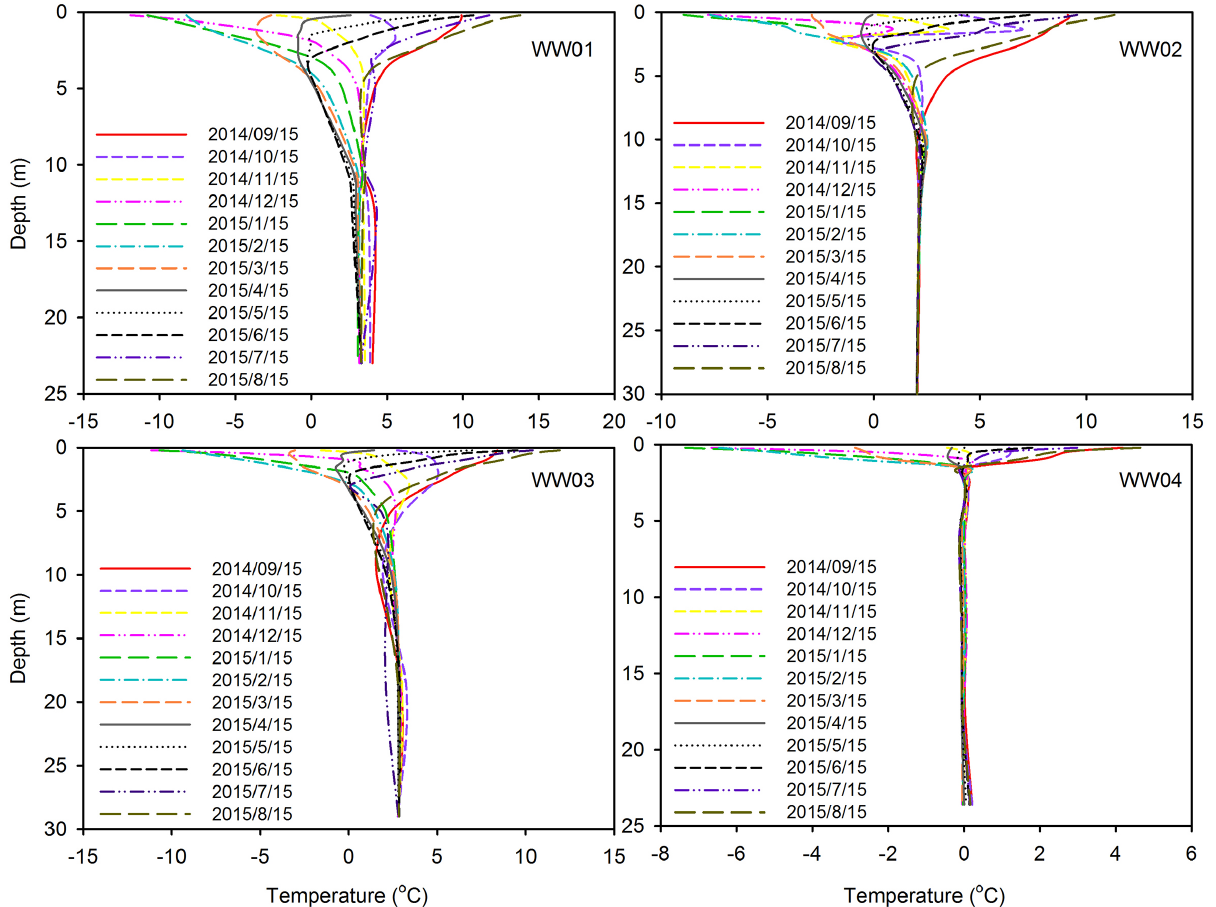
Figure 5. Temperature envelopes in the sediments at clusters WW01, WW02 and WW03 within the seasonal frost zone, as well as cluster WW04 within the permafrost